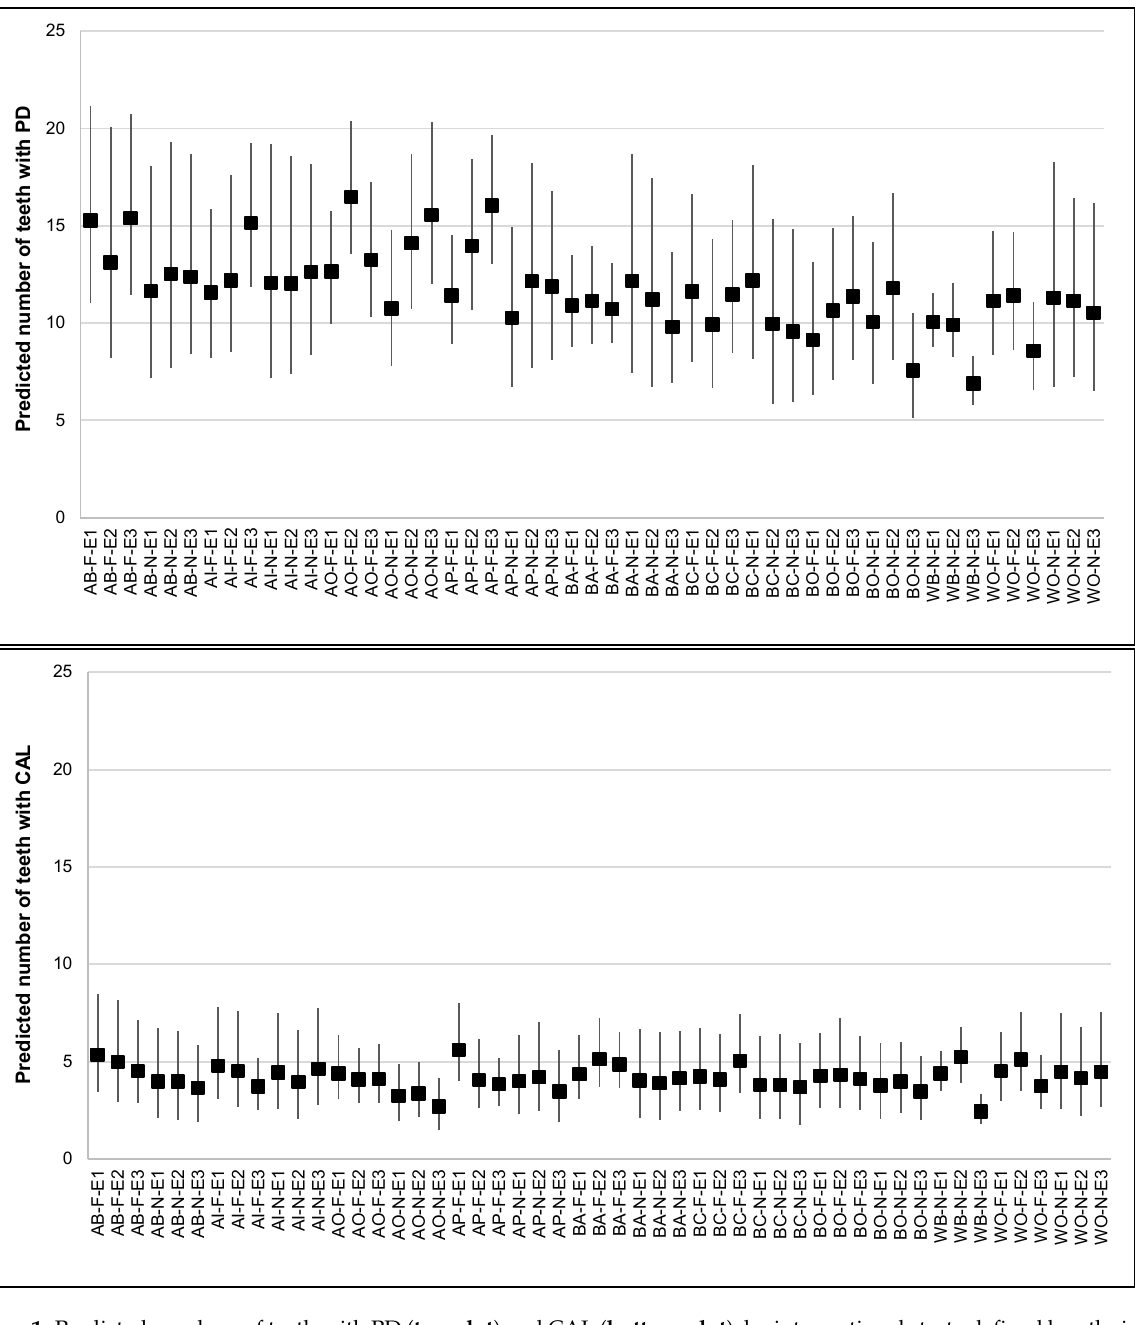
Figure 1. Predicted numbers of teeth with PD ( top plot ) and CAL ( bottom plot ), by intersectional strata defined by ethnicity (AB: Asian Bangladeshi, AI: Asian Indian, AO: Asian Other, AP: Asian Pakistani, BA: Black African, BC: Black Caribbean, BO: Black Other, WB: White British, and WO: White Other), nativity status (N: Native; F: Foreign) and education (E1: low, E2: medium, and E3: high). Predictions were based on the simple intersectional model. Markers indicate estimated effects, and whiskers indicate 95% credible